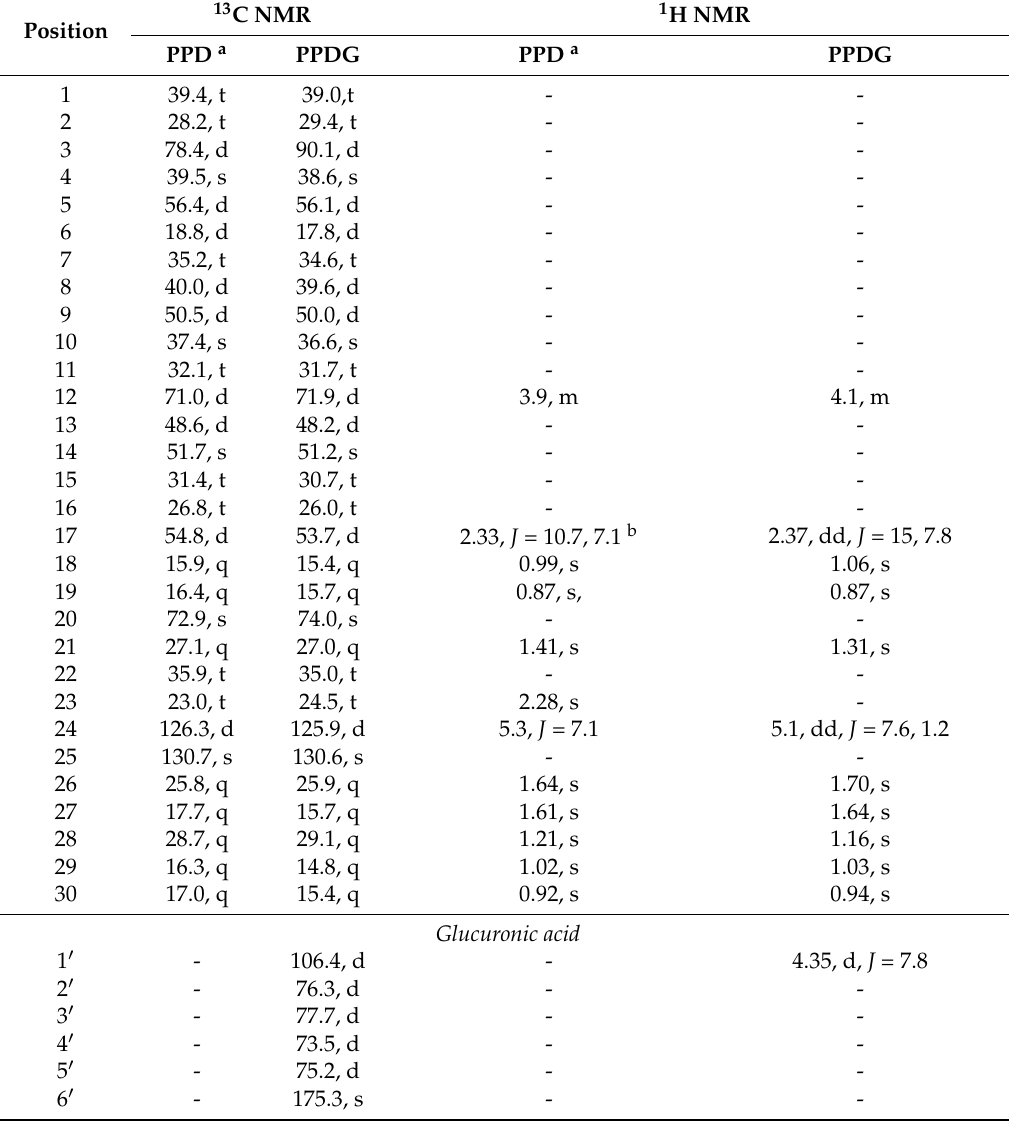
Table 1. 1 H and 13 C NMR data of 20( S )-protopanaxadiol (PPD) and its glucuronidation metabolite (PPDG) (600 MHz, methanol- d 4